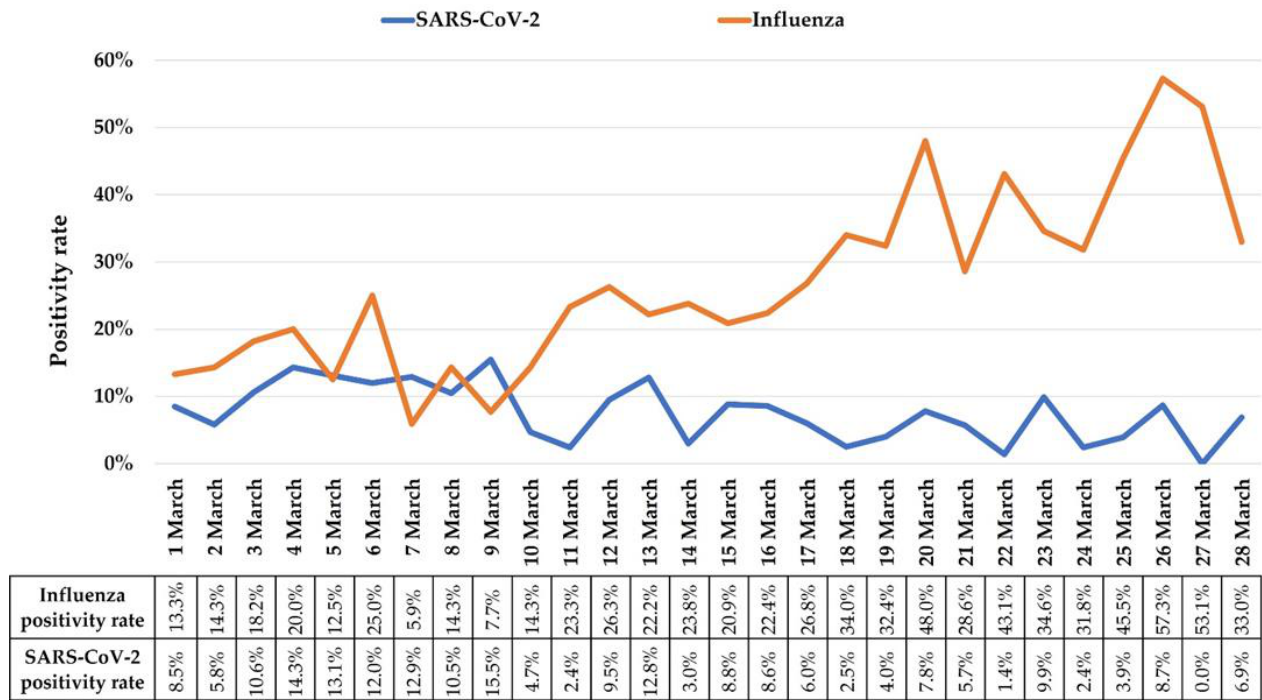
Figure 1. Daily distribution of influenza and SARS-CoV-2 positivity rates.